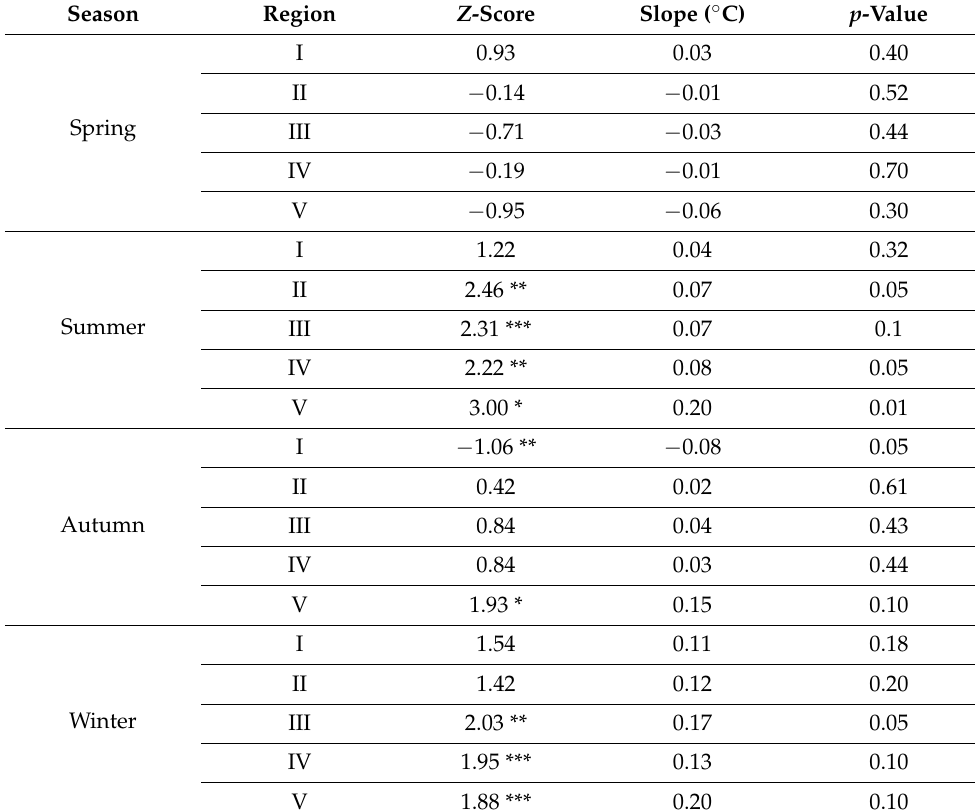
Table 3. The mean LST difference along with standard deviation at seasonal scales.